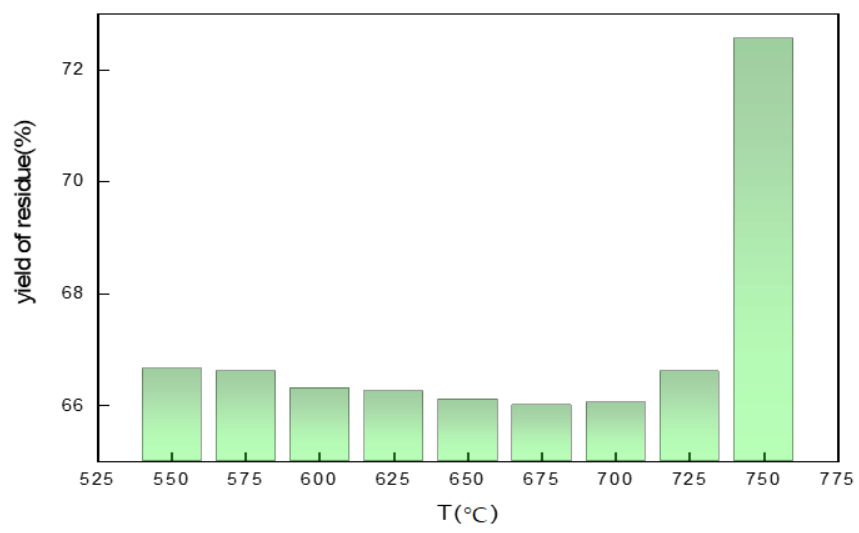
Figure 8. Effects of calcination temperature on the yield of residue.